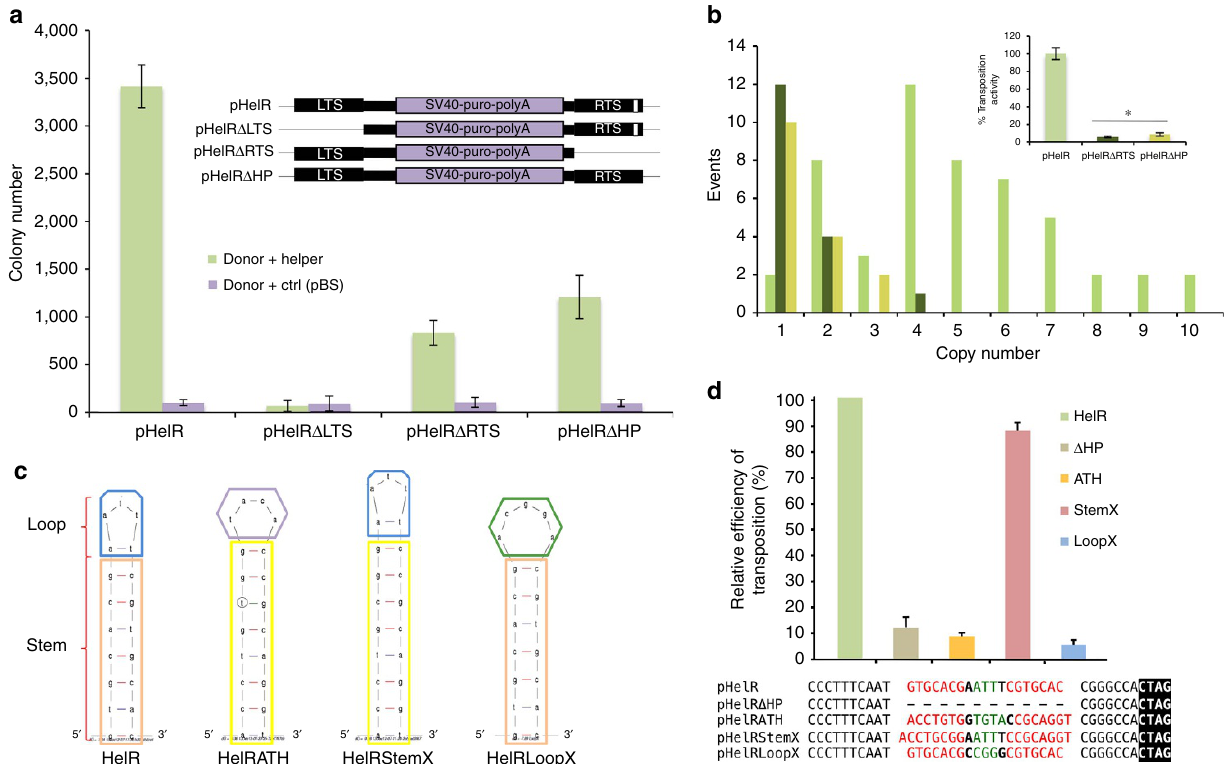
Figure 3 | Role of the 3 0 -terminal sequences and hairpin structure in Helraiser transposition. ( a ) Colony-forming efficiencies of the pHelR, pHelR D LTS, pHelR D RTS and pHelR D HP donors. Data are represented as mean ± s.e.m., n ¼ 3 biological replicates. ( b ) Average transposon copy numbers per clone